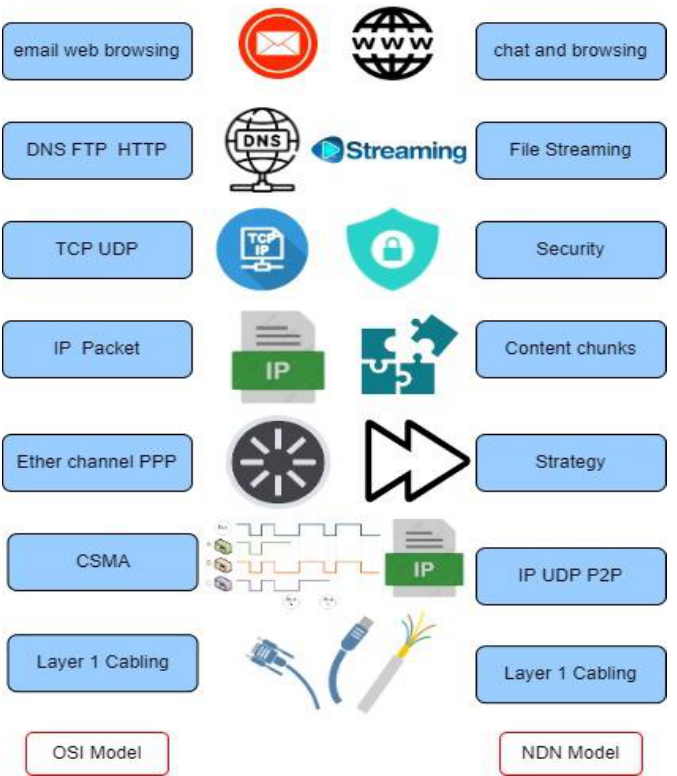
Figure 1. Comparison of the OSI model and the NDN model.